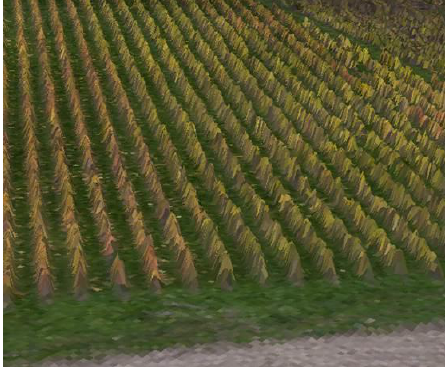
Figure 6. Textured DSM extracted